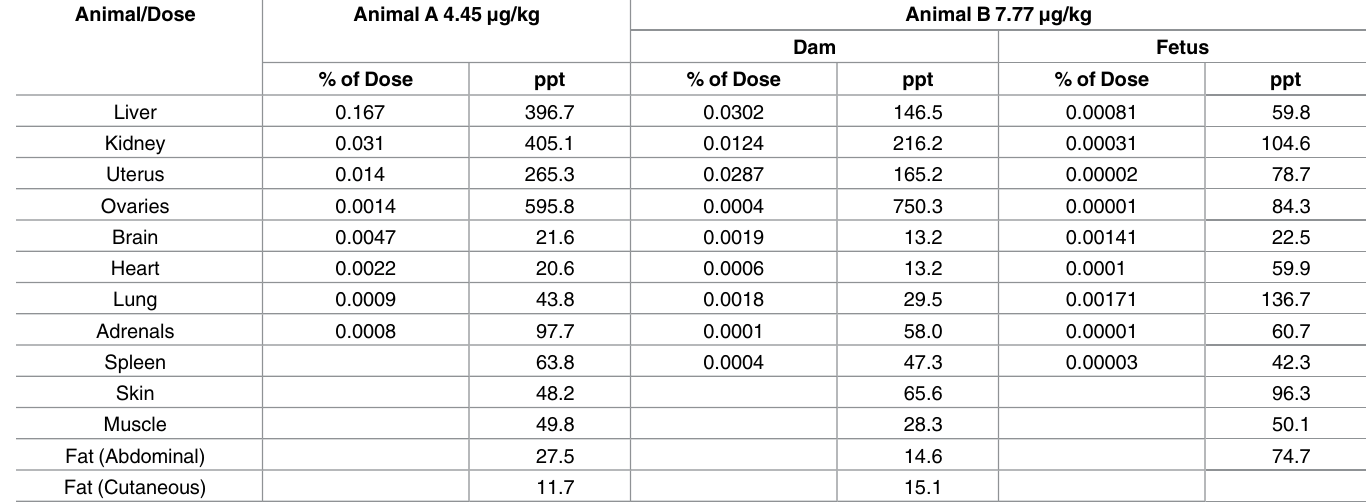
Table 5. 3 H residue levels in adult and fetal tissues and fluids, at 24 hr, in an adult female Rhesus macaque (A) orally dosed with 4.5 μ g/kg BW 3 H-BPA, and in a gravid dam (B) orally dosed with 7.8 μ g/kg BW 3 H-BPA, and the respective fetus. Results are expressedin ppt (ng/g) of BPA equiva- lents. Percent (%) of dose is the percentageof the administered